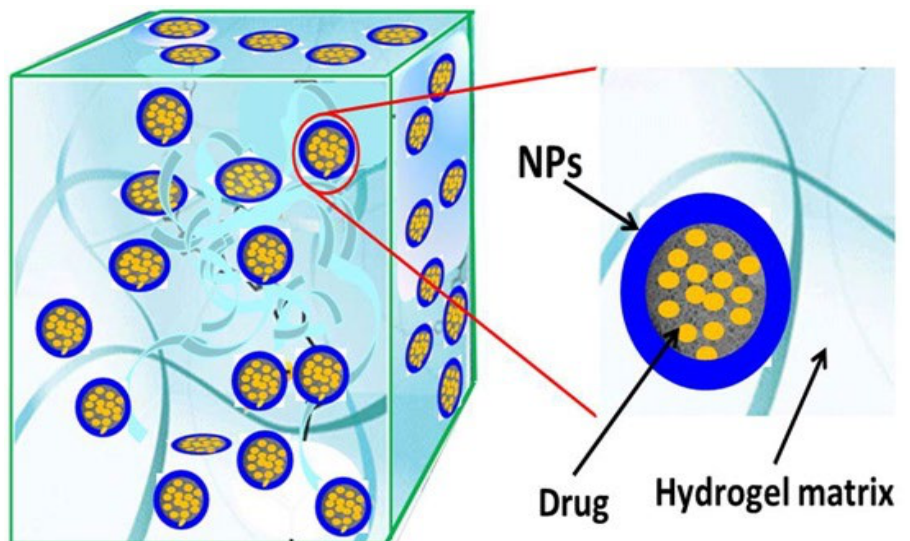
Figure 8. Schematic of the composition of nanocomposite cross-linked gels with a hydrogel dispersion matrix and drug-loaded nanoparticles. [Obtained and re-produced without any changes from [172] and Nanomaterials MDPI in accordance with Creative Commons Attribution License (CC BY 4.0)].